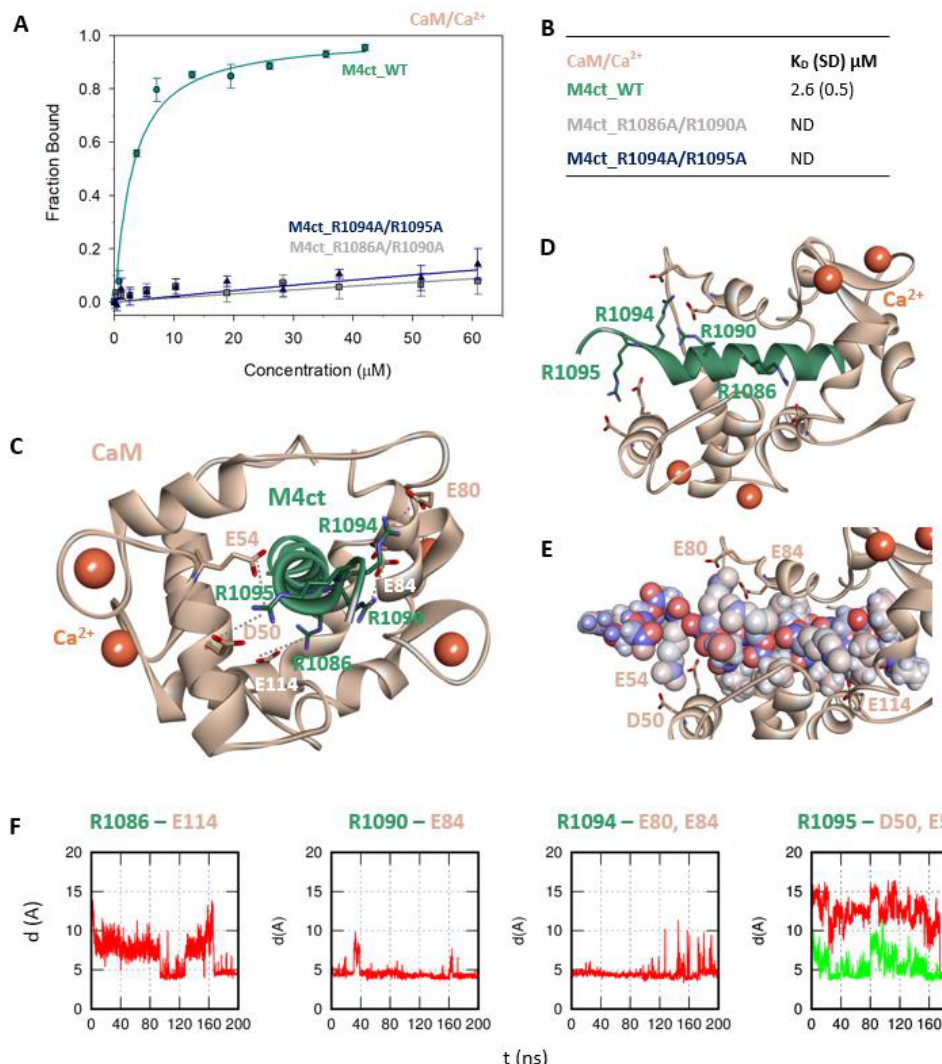
Figure 4. The M4ct / CaM complex. ( A ) The F B of fluorescently labelled M4ct_WT (circles), M4ct_R1086A / R1090A (squares) and M4ct_R1094A / R1095A (up-triangles) as a function of CaM (beige) concentrations. M4ct peptides were titrated by CaM, and F B was calculated according to Equation (1); the solid lines represent the best fit to the binding isotherm from Equation (2) (Methods). ( B ) The equilibrium K D of the M4ct-binding epitope in complexes with CaM obtained by steady-state FA. ( C ) M4ct / CaM in the context of the whole CaM in the presence of Ca 2 + as a result of MDs. The side chains of the M4ct (ribbon representation, green colour) amino acids involved in salt bridges with their binding counterparts from CaM (ribbon representation, beige colour) in atomic detail displayed as sticks: R1086-E114, R1090-E84, R1094-E80, E84 and R1095-D50 and E54. ( D ) The M4ct / CaM complex from the upper view; M4ct and CaM are shown in the same representation as Figure 4C, with displayed R1086, R1090, R1094 and R1095 basic residues (stick representation, green color) involved in the interactions with CaM. ( E ) The M4ct / CaM complex from a detailed upper view; M4ct is shown in CPK representation (partial charge colouring), CaM displayed with D50, E54, E80, E84 and E114 negatively charged residues (stick representation, beige colour) involved in the interactions with M4ct. Ca 2 + displayed in a ball representation, orange colour. ( F ) Time-dependent geometry characteristics of the studied salt bridges R1086-E114, R1090-D84, R1094-E80 and E84 and R1095-D50 and E54 from MD simulations. A stable salt bridge is expected to have a distance of about 5Å between the termini of oppositely charged amino acids.